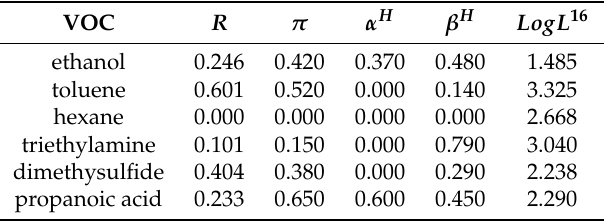
Table 1. Linear Sorption-Energy Relationship (LSER) parameters of the tested volatile organic compounds (VOCs), R is the polarizability, π > the dipolarity, α H and β H the hydrogen bond acidity and basicity, and LogL 16 is the solubility term [17]. VOC R